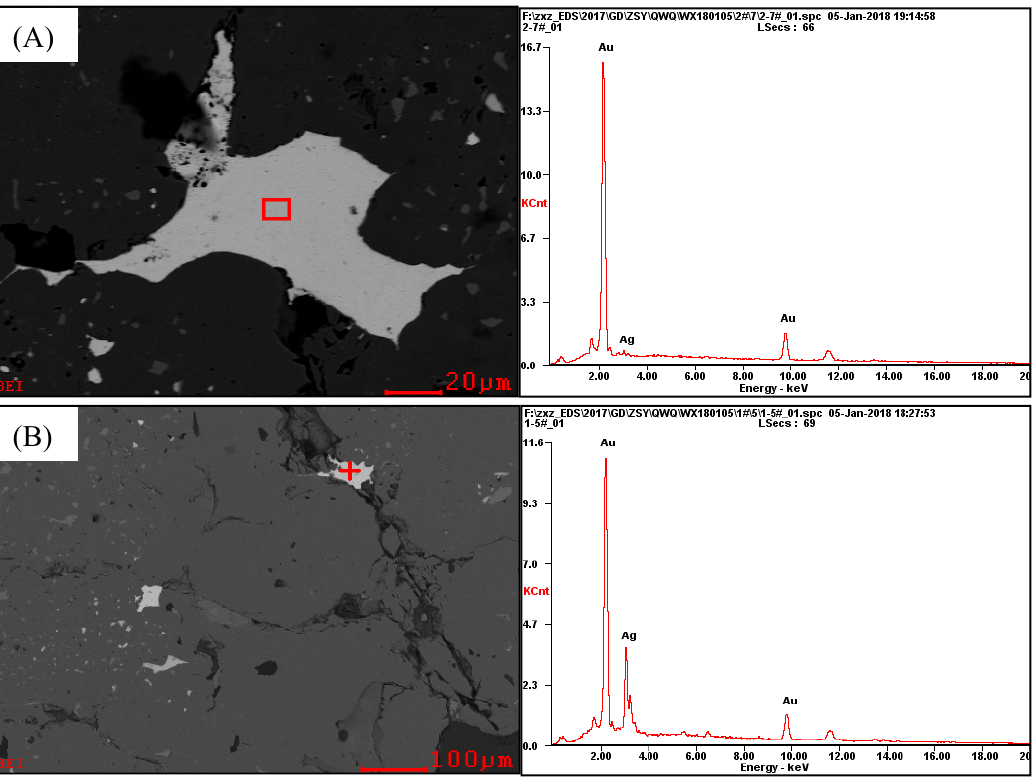
Figure 3. SEM images and EDS analysis of gold in pyrite: ( A ) enclosing gold in pyrite; ( B ) intergranular gold in pyrite .